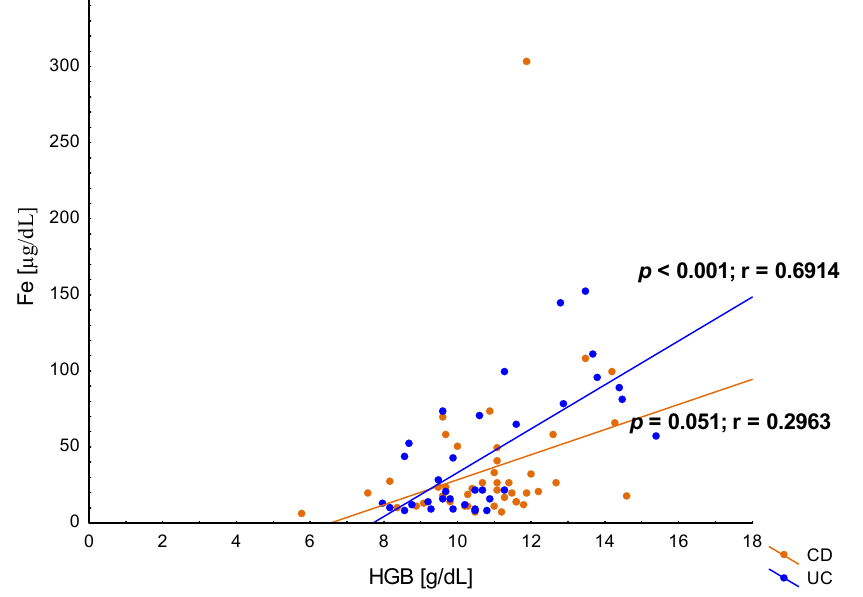
Figure 3. The correlation between iron (Fe) and haemoglobin (HGB) concentration in patients with ulcerative colitis (UC) and Crohn’s disease (CD).